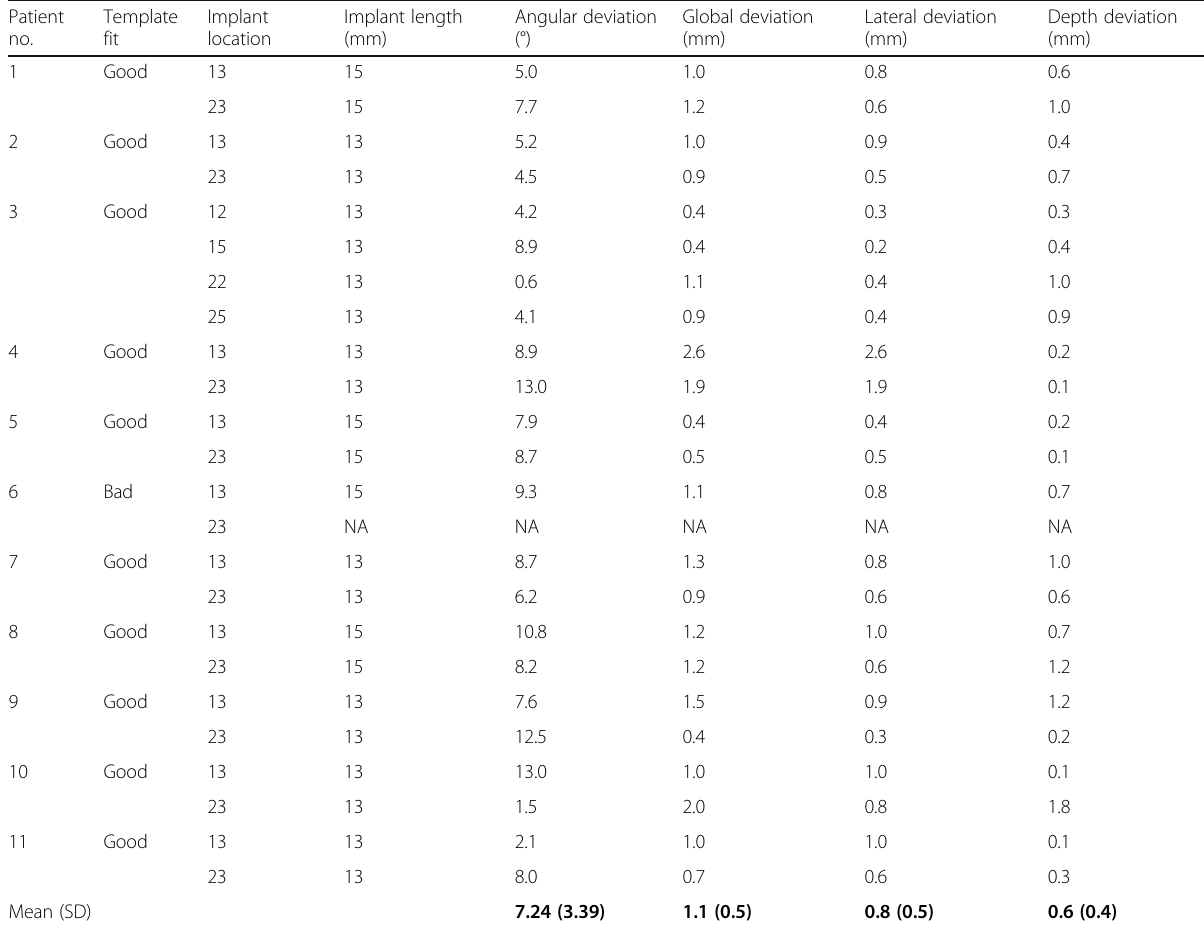
Table 1 Template fit and deviations at the entry point of placed implants Patient